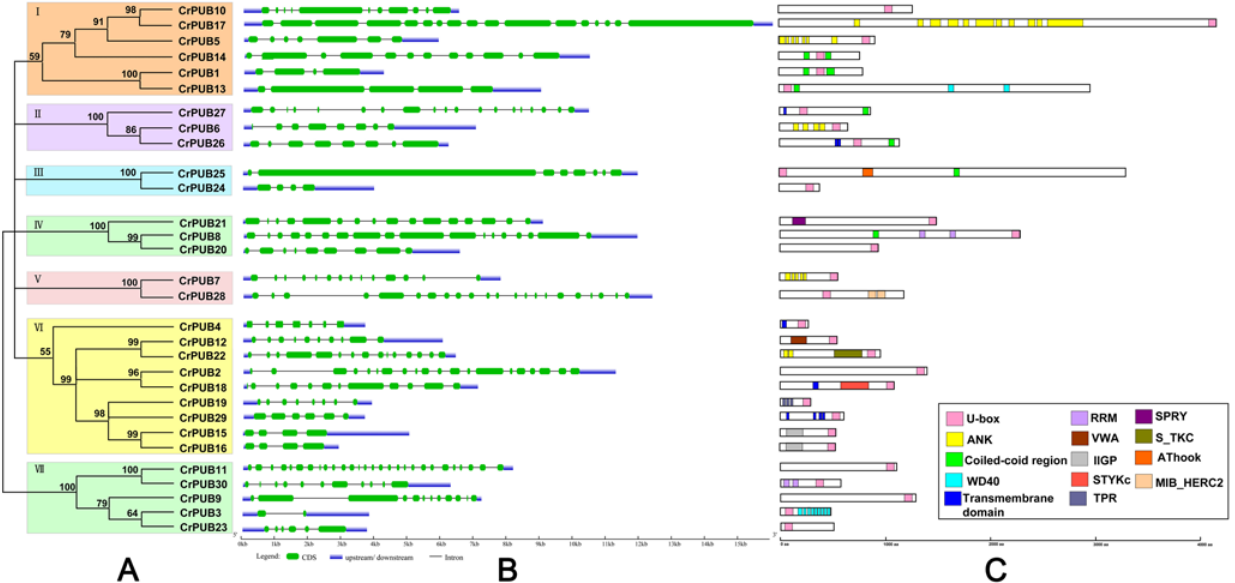
Fig 2. An analytical view of the CrPUB gene family. A. An unrooted tree summarizing the evolutionary relationships among the 30 members of the CrPUB family. Multiple alignments of the 30 PUB protein sequences from C . reinhardtii were conducted using ClustalX 2.1. The phylogenetic tree was constructed using PhyML3.01 and the ML method with 1,000 bootstrap replicates. The numbers on each node are Shimodaira-Hasegawa-like test indices of statistical support provided by PhyML. Bar = 2.0 is a branch length that represents the number of amino acid substitutions per site. The tree shows the 3 phylogenetic subfamilies (numbered I to III and marked with different color backgrounds) with high predictive values. B. Intron/exon structure: The gene structures were drawn using the online tool GSDS. As shown in the legend, the exons and introns are indicated by green rectangles and thin lines, respectively. The untranslated regions (UTRs) are indicated by blue boxes. The sizes of exons and introns can be estimated using the scale shown at the bottom. C. Schematic representation of the conserved motifs in the 30 CrPUB proteins elucidated using SMART and PROSITE online. The different domains are indicated by different colored boxes denoted at the bottom right corner. The lengths of the proteins and motifs can be estimated using the scale shown at the bottom.